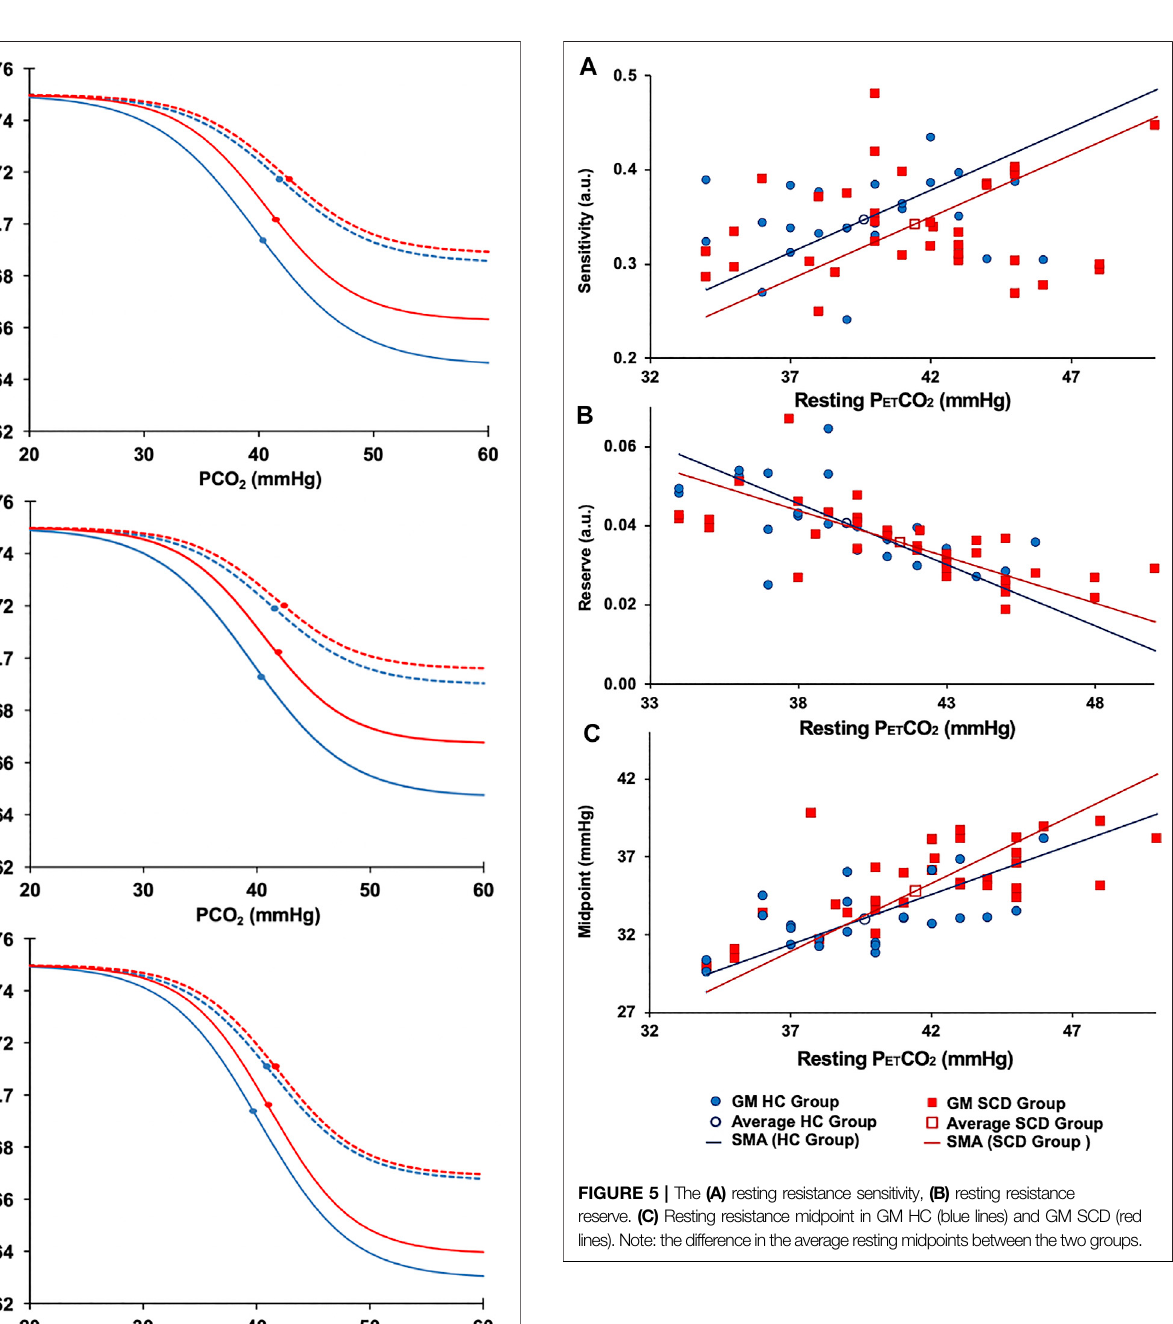
Frontiers in Physiology |